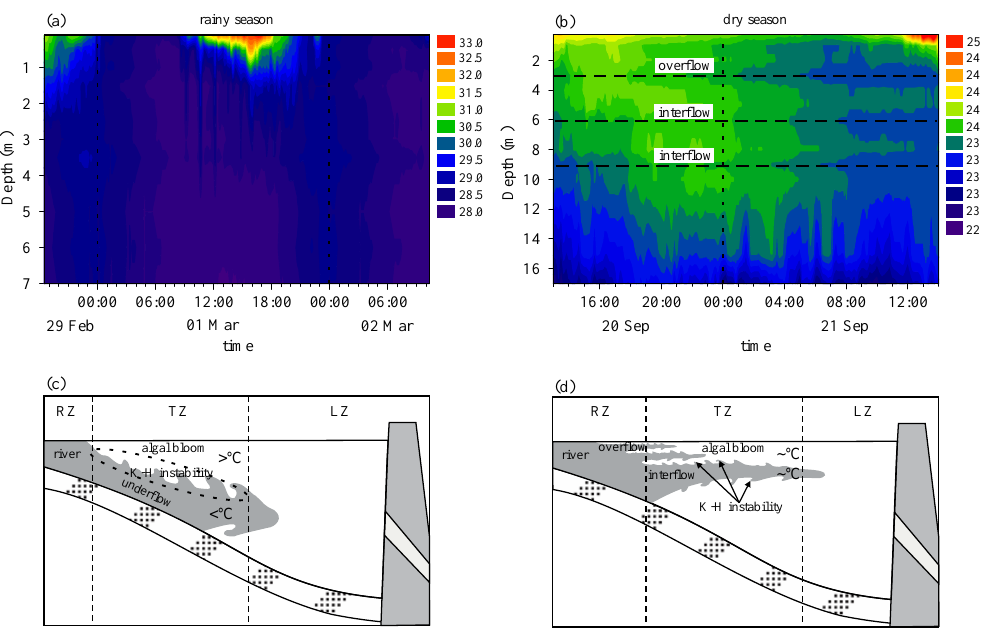
Figure 5. The temperature profile collected at station S09 during the rainy season (a) and at station S14 during the dry season (b) . The dashed line represents the depths where the river flows as overflow or interflows. During the rainy season, the river plunges and flows under the reservoir (underflow) due to differences in density (c) . The waves and billows develop along the interface due to the shear velocity (Kelvin–Helmholtz instability) and facilitate vertical mixing (see text). During the dry season, the river flows as overflow or interflow (d) because the difference in the density between the river and reservoir is low. In this situation, the river can influence the reservoir surface water more 5km toward the dam. RZ: riverine zone; TZ: transition zone; LZ: lacustrine